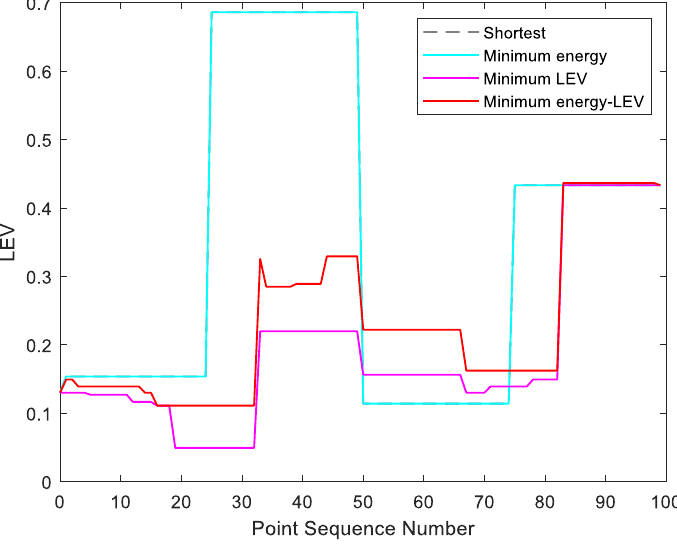
Figure 19. The LEV in the experiments.